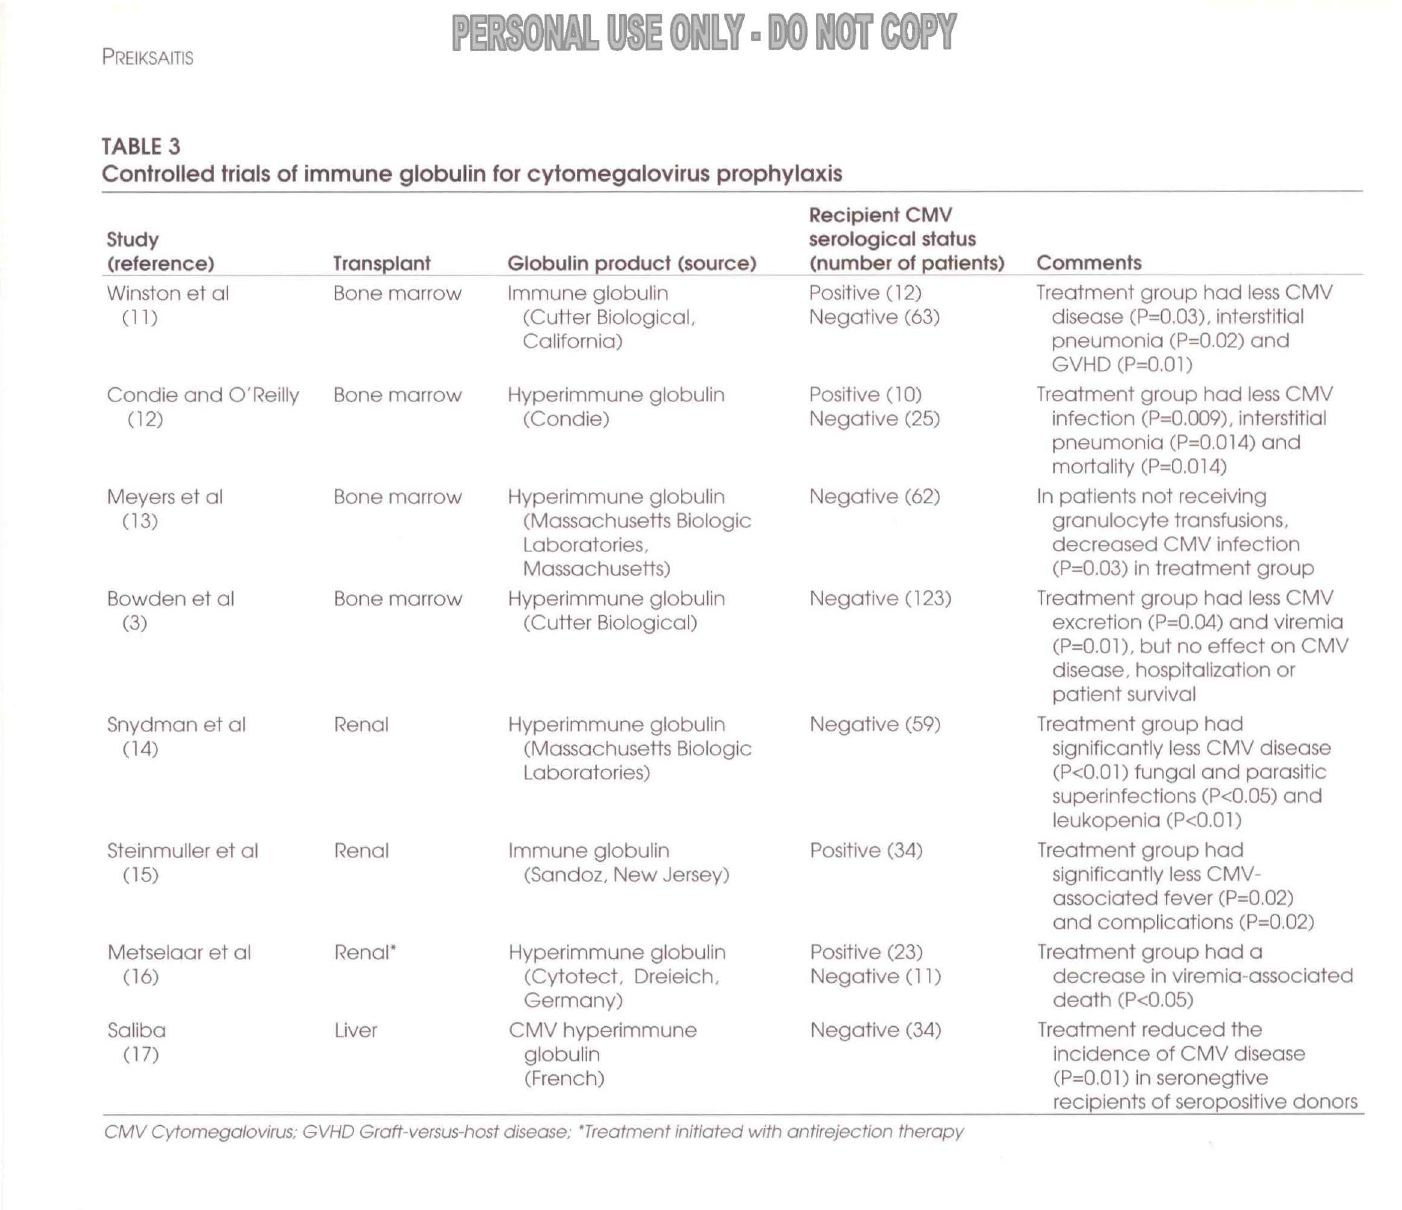
Controlled trials of immune globulin for cytomegalovirus